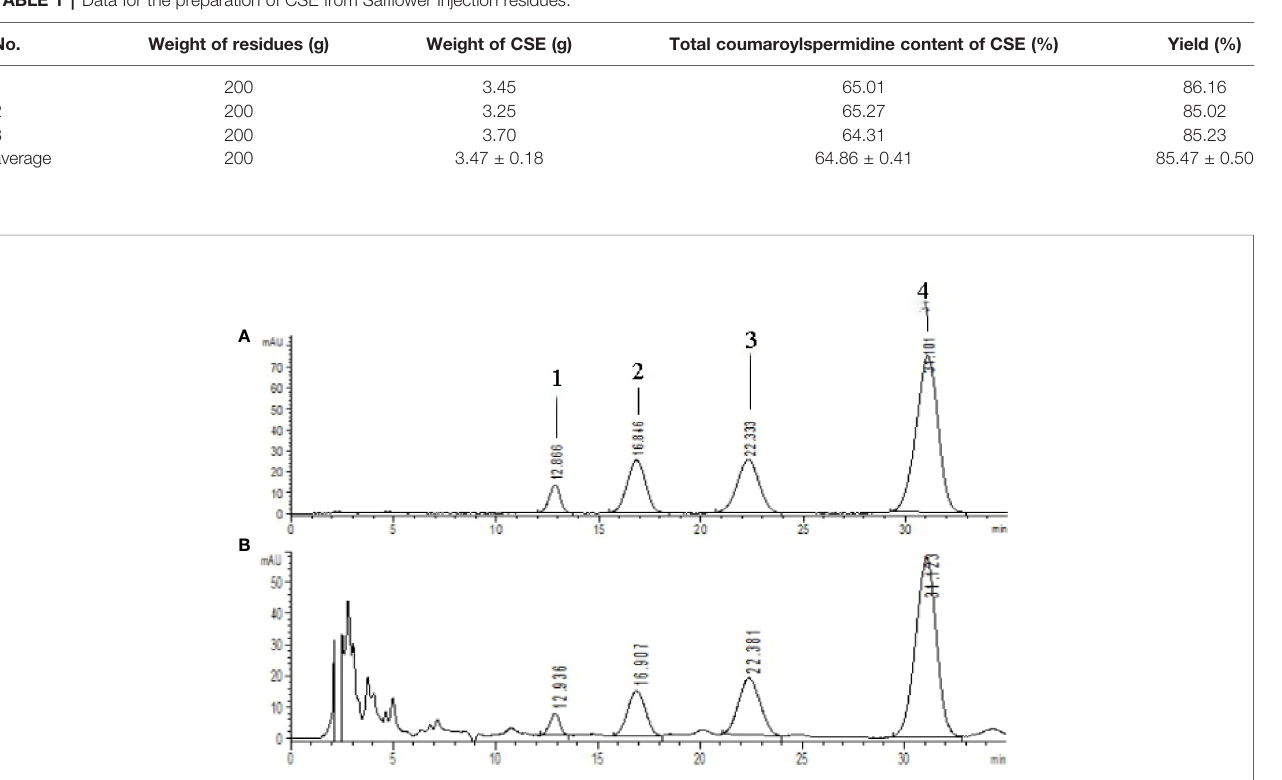
FIGURE 3 | HPLC chromatograms of standards and CSE [ l =280 nm, (A) coumaroylspermidine standards, (B) CSE]. Compouds 1 - 4 represents the corresponding four coumaroylspermidine products.